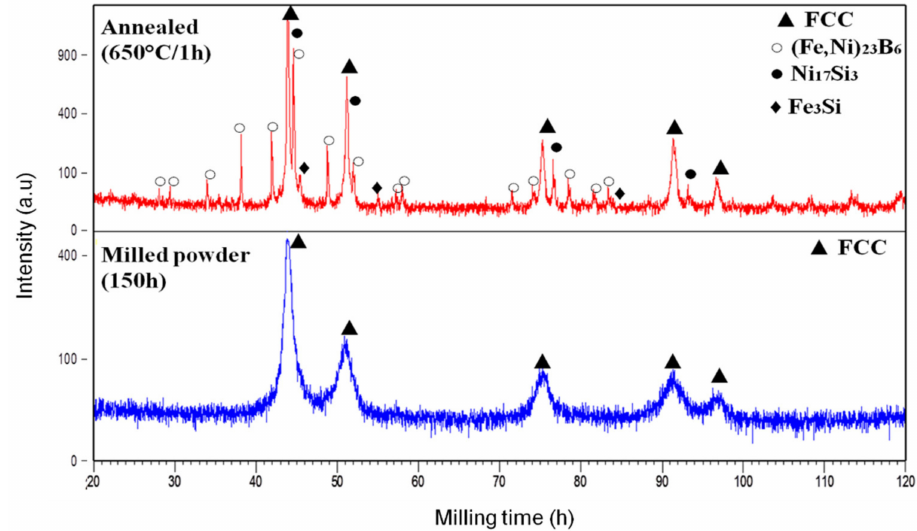
Figure 6. X-ray di ff raction patterns of mecanically alloyed FeCoNiB 0.5 Si 0.5 powders for 150 h of milling and after annealing at 650 ◦ C for 1